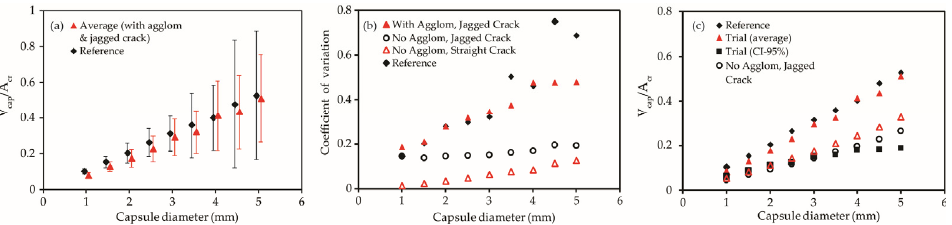
Figure 17. Effect of capsule agglomeration and crack geometry on the variation in fill ratio. ( a ) Com- parison of variances between numerical study and simulation; ( b ) Uncertainty in data with different crack geometry; ( c ) Effect of crack geometry on average fill ratio.